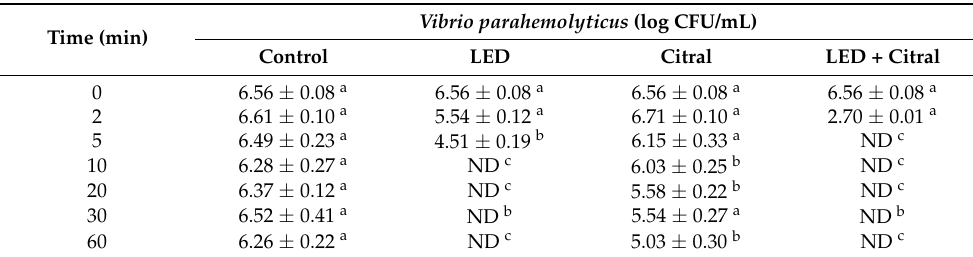
Table 1. Inactivation of Vibrio parahaemolyticus by combination of 405 nm LED illumination and citral in PBS. Time (min)